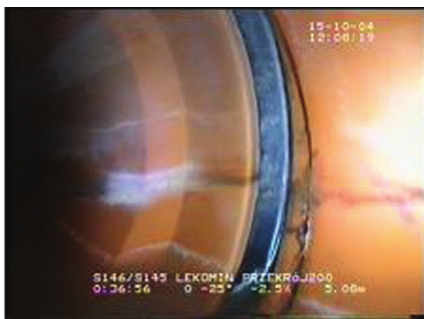
Fig. 6. Longitudinally displaced joint with a visible gasket